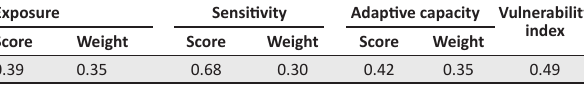
TABLE 5: Flood vulnerability index of Klaten